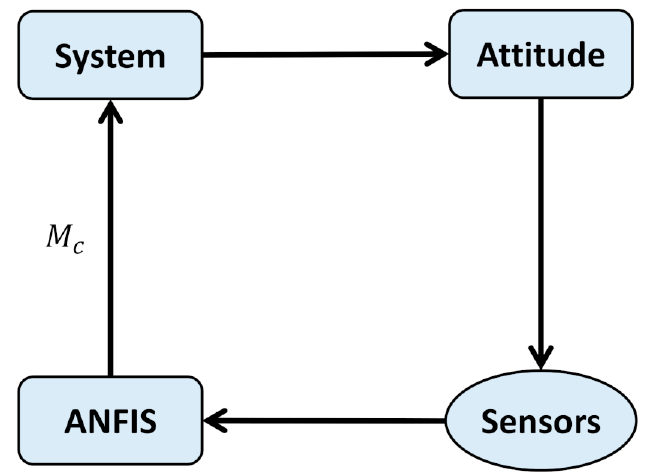
Figure 6. Block diagram of the control system using the ANFIS integrated controller and observer.